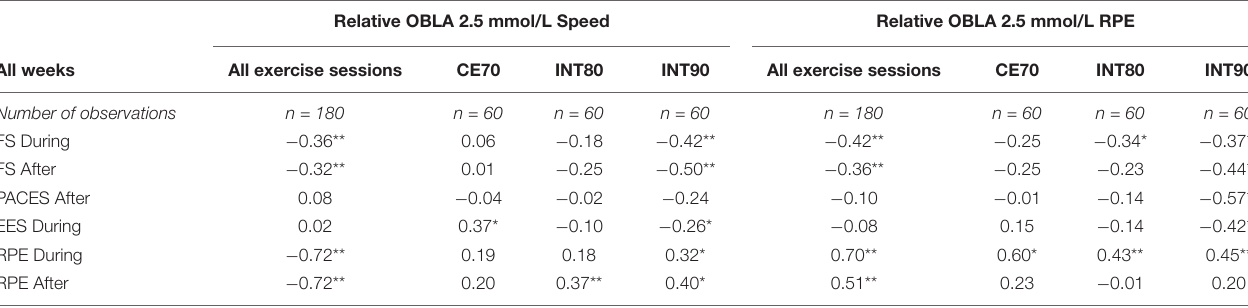
TABLE 5 | Correlations of perceptual responses from all exercise sessions and weeks and relative OBLA 2.5 mmol/L speed and RPE.